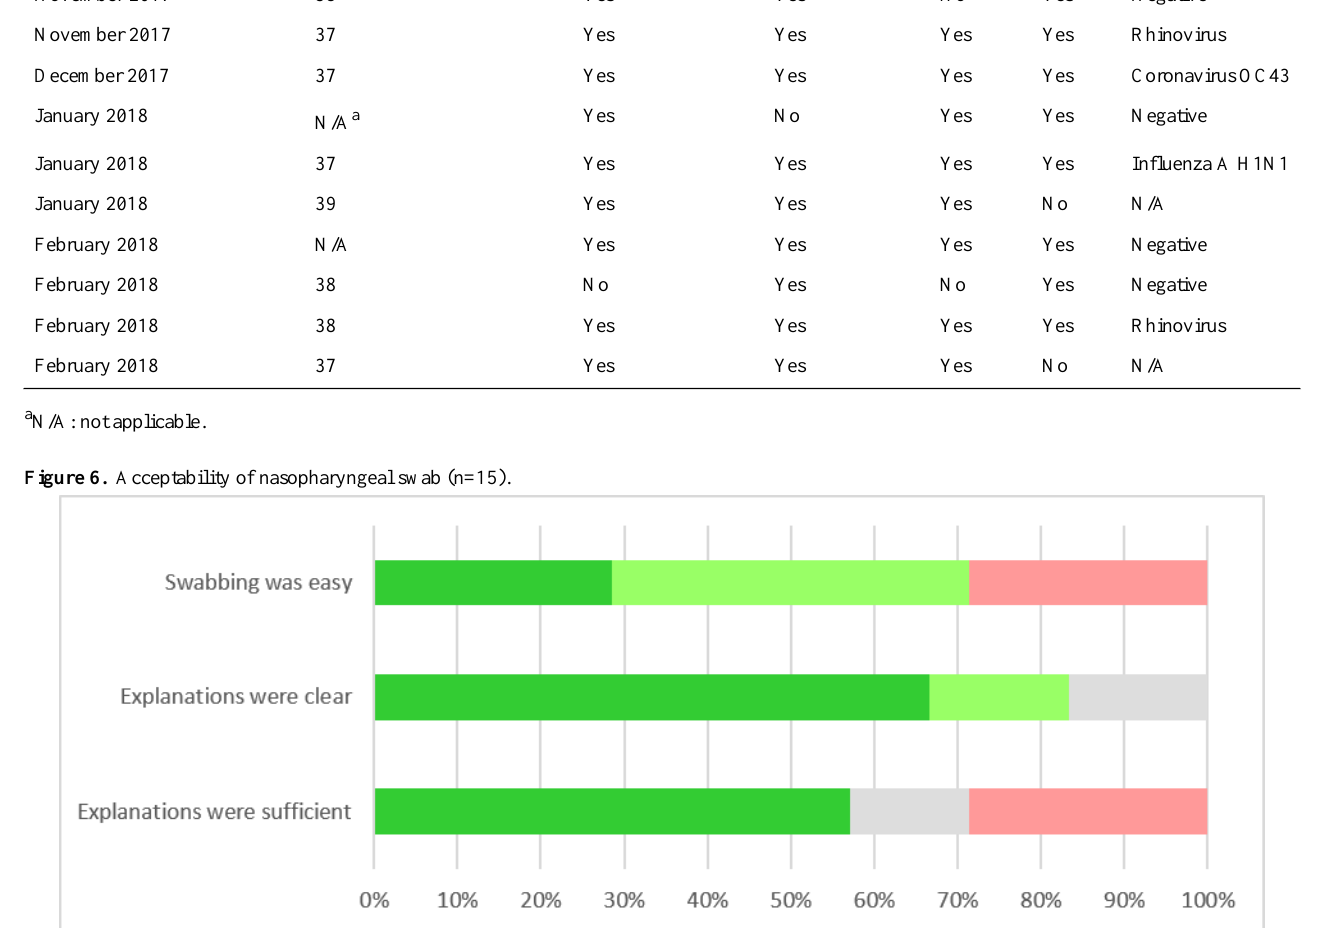
ResultSwabCoughSore throatFever historyTemperature (°C)Month